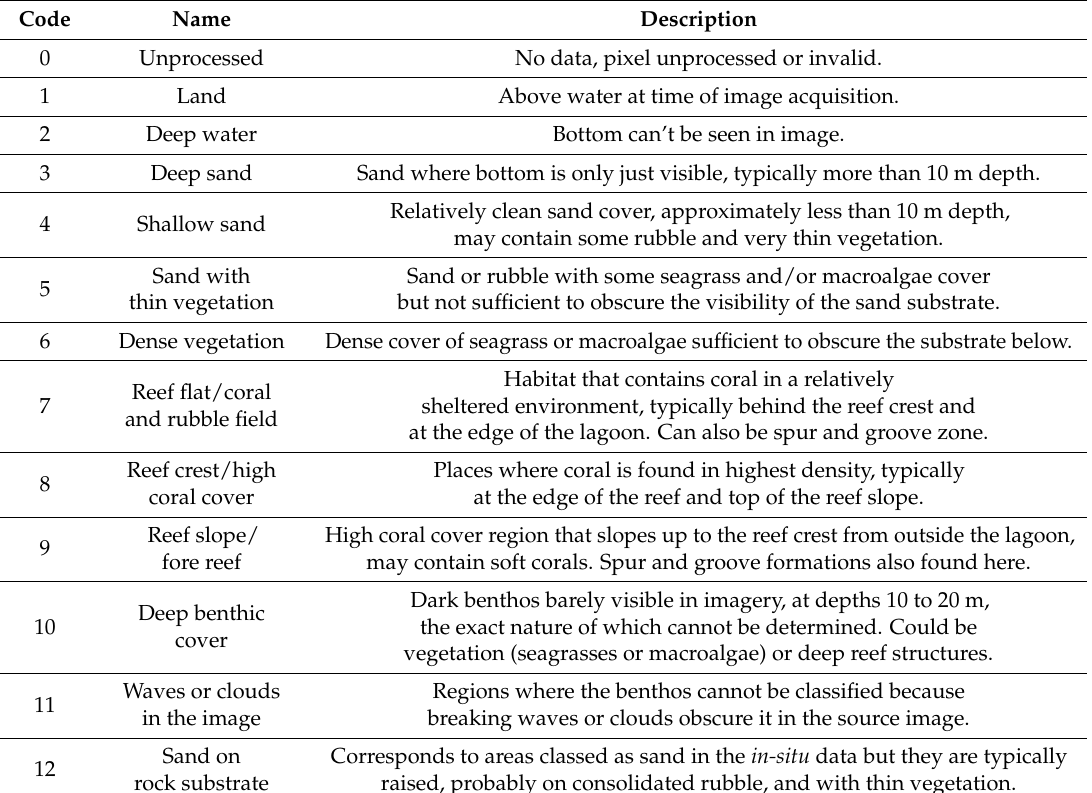
Table 3. Habitat classification scheme applied in the GEM mapping production